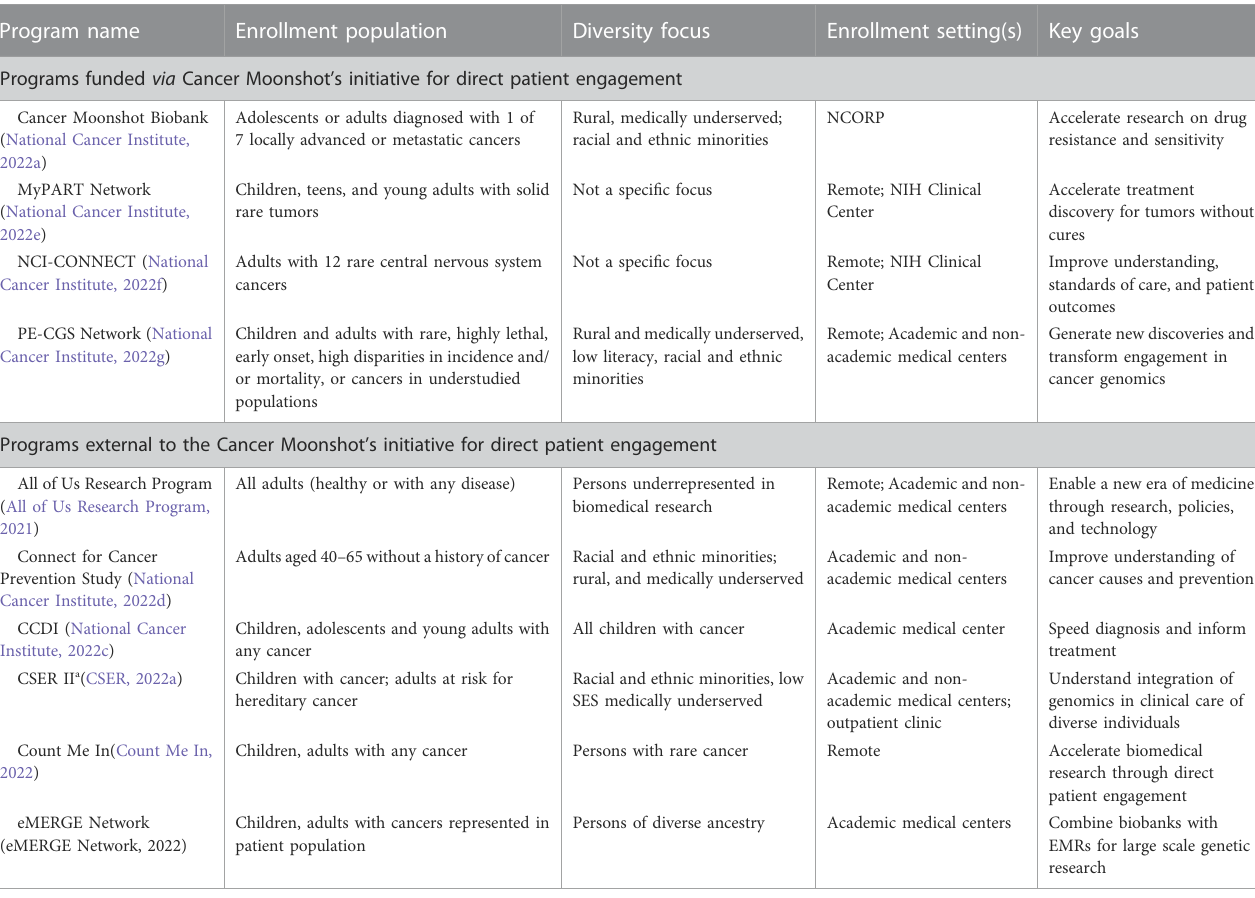
TABLE 1 Research programs and key information about their populations, protocols, and